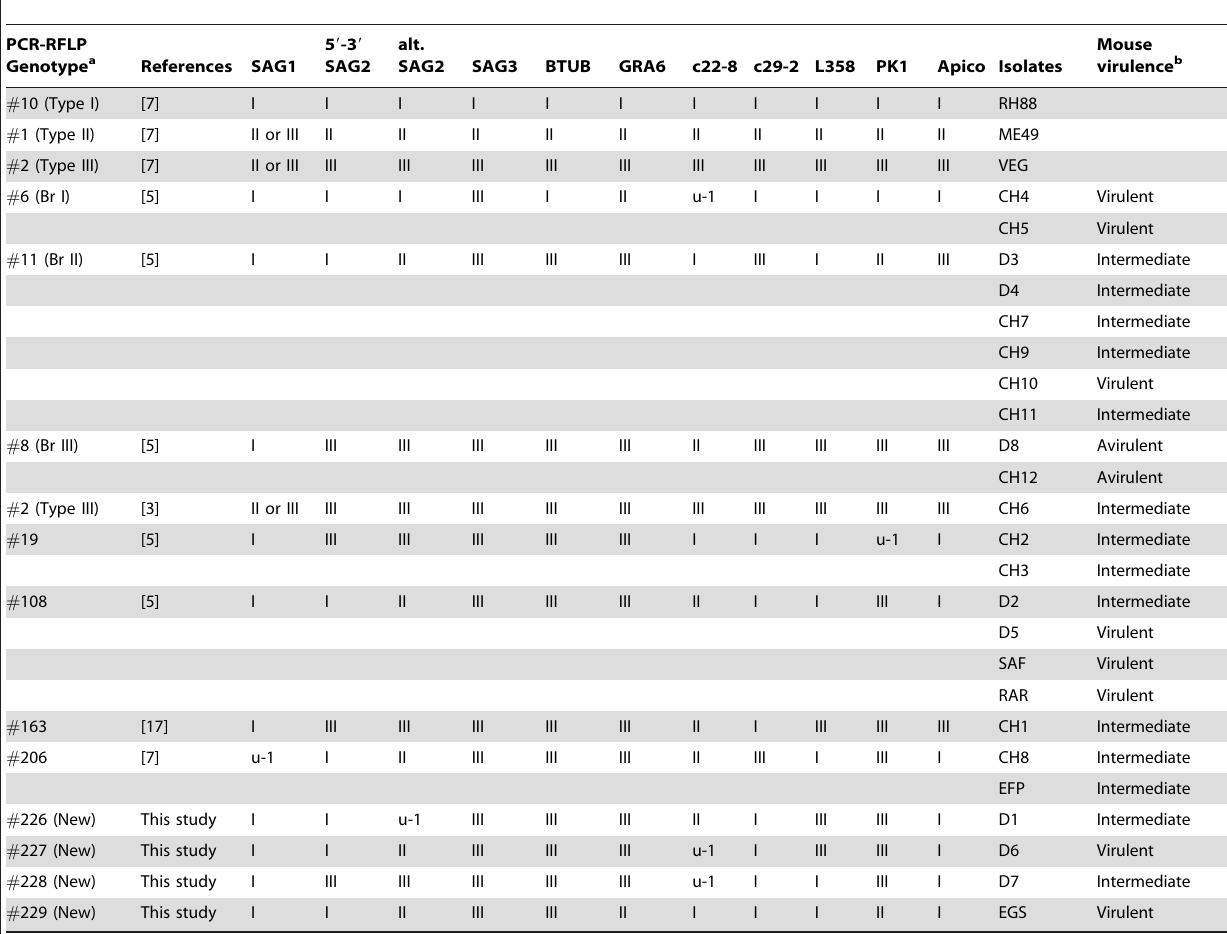
Table 1. Multilocus PCR-RFLP genotyping of Toxoplasma gondii isolates from human and domestic animals in Minas Gerais,